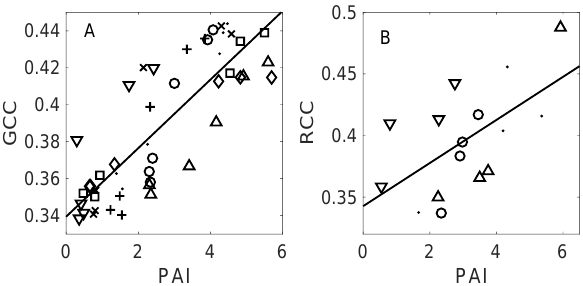
Figure 5. Scatter plots and lines of best fit between PAI values from upward photography and ( A ) G CC values from drone imagery in spring (N = 48, eight microsites); ( B ) R CC values after the maximum R CC in fall, for microsites with one or more observations between the fall maximum of R CC and the last observation (N = 16, four microsites). Different microsites are indicated by distinct symbols. The pooled-data regression equations are G CC = 0.34 + 0.019*PAI (r = 0.84, p < 0.001) and R CC = 0.34 + 0.017*PAI (r = 0.60, p < 0.05). Microsite-level correlations reported in Table